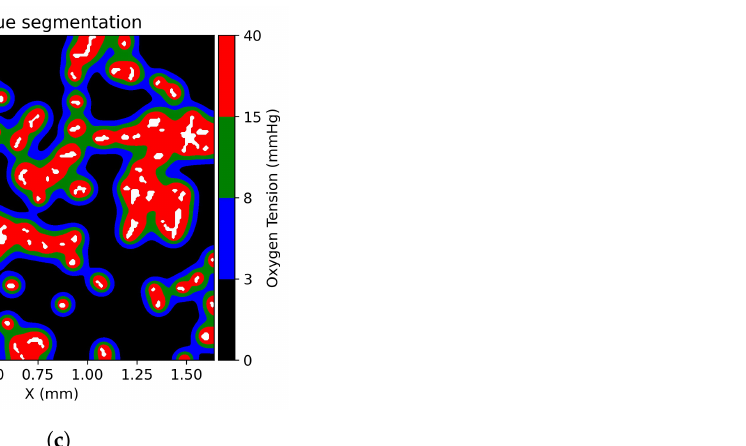
Figure 2. Tissue segmentation of the three representative ROIs based on the oxygenation level. Physoxia is labeled with red color, physiological hypoxia is labeled with green color, pathological hypoxia is labeled with blue color, and radiobiological hypoxia is labeled with black color. ( a ) Tissue segmentation for ROI A with a vascular fraction of 1%. ( b ) Tissue segmentation for ROI B with a vascular fraction of 2.34%. ( c ) Tissue segmentation for ROI C with a vascular fraction of 3.2%.